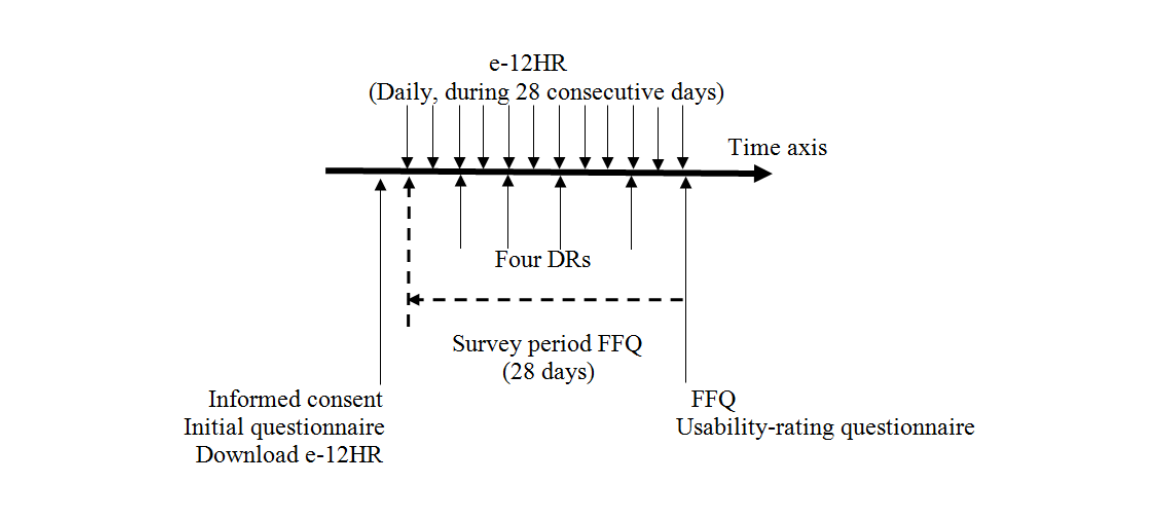
Figure 1. Assessment process using the electronic 12-hour dietary recall (e-12HR) app, 4 dietary records (DRs), food frequency questionnaire (FFQ), and usability rating questionnaire for the e-12HR